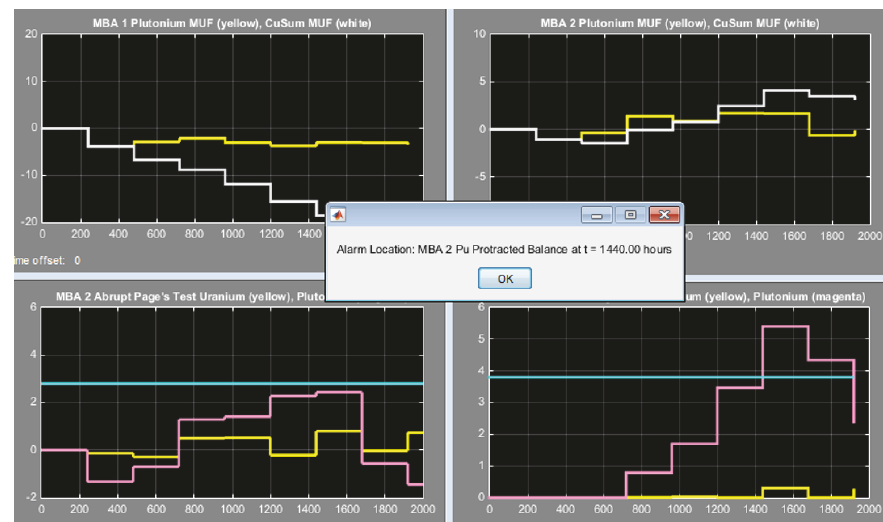
Figure 3: Example protracted loss scenario using the SSPM. The top plots show the MUF and cumulative sum of MUF for Pu for two MBAs, and the bottom plots show the abrupt and protracted Page’s test. The Page’s test threshold (lower right) was surpassed, indicating a diversion.